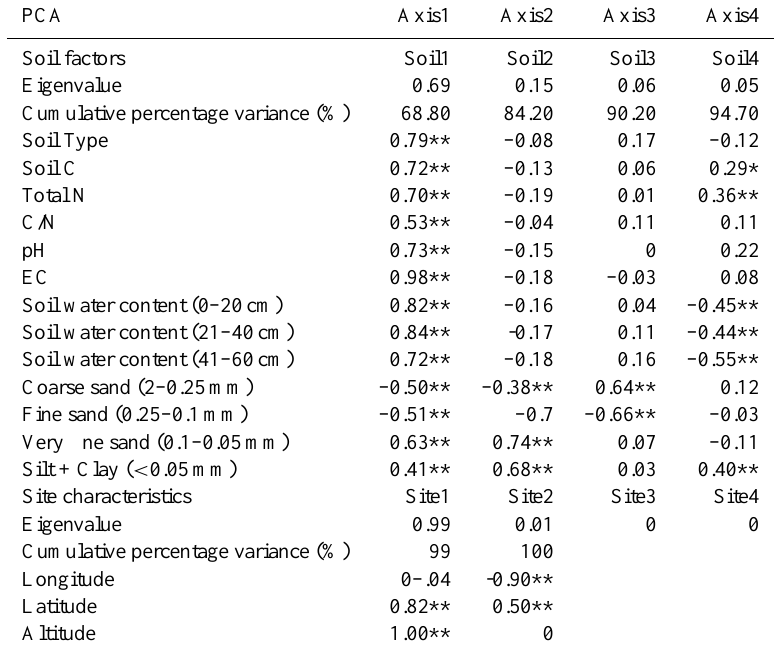
Table A4. Eigenvalues and eigenvector coefficients (loadings) of a standardized principal component analysis (PCA). PCA was performed separately for edaphic factors, site characteristics and management